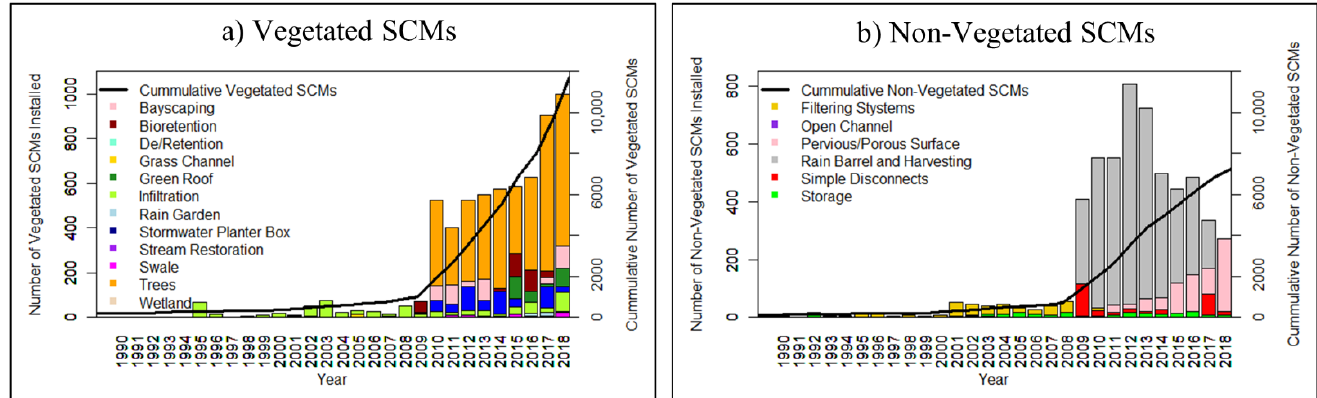
Figure 1. Installation of ( a ) Vegetated and ( b ) Non-vegetated stormwater control measures (SCMs) from 1990 to 2018 in Washington, DC.